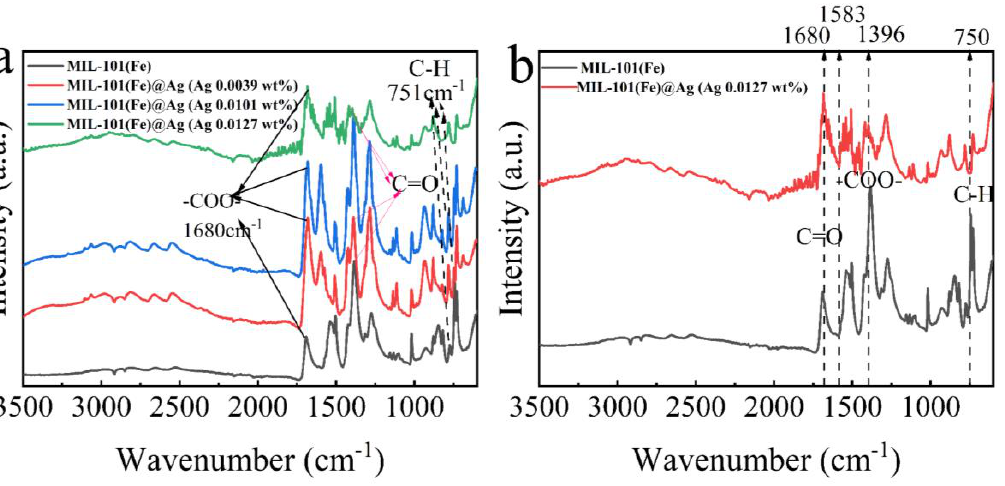
Figure 3. ( a ) FTIR spectra of MIL-101(Fe) and MIL-101(Fe)@Ag. ( b ) Comparison of the FTIR spectra of MIL-101(Fe) and MIL-101(Fe)@Ag (Ag 0.0127